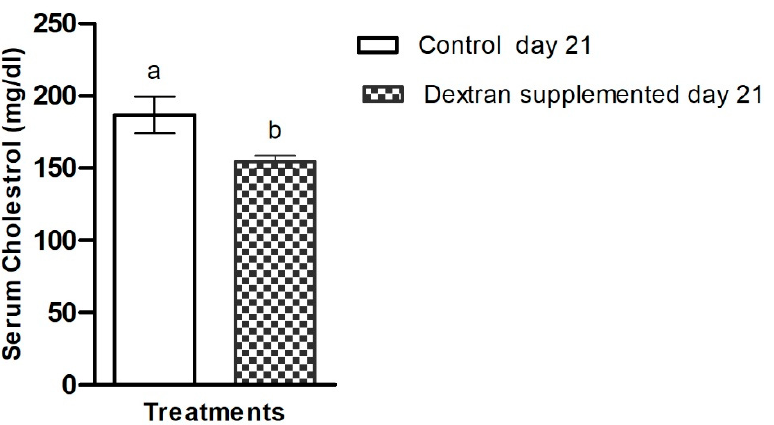
Figure 9. Serum cholesterol level of Apilactobacillus waqarii EPS with control in experimental animals. The values of data sets ( n = 6) denoted by different alphabet are significantly different ( p < 0.05).